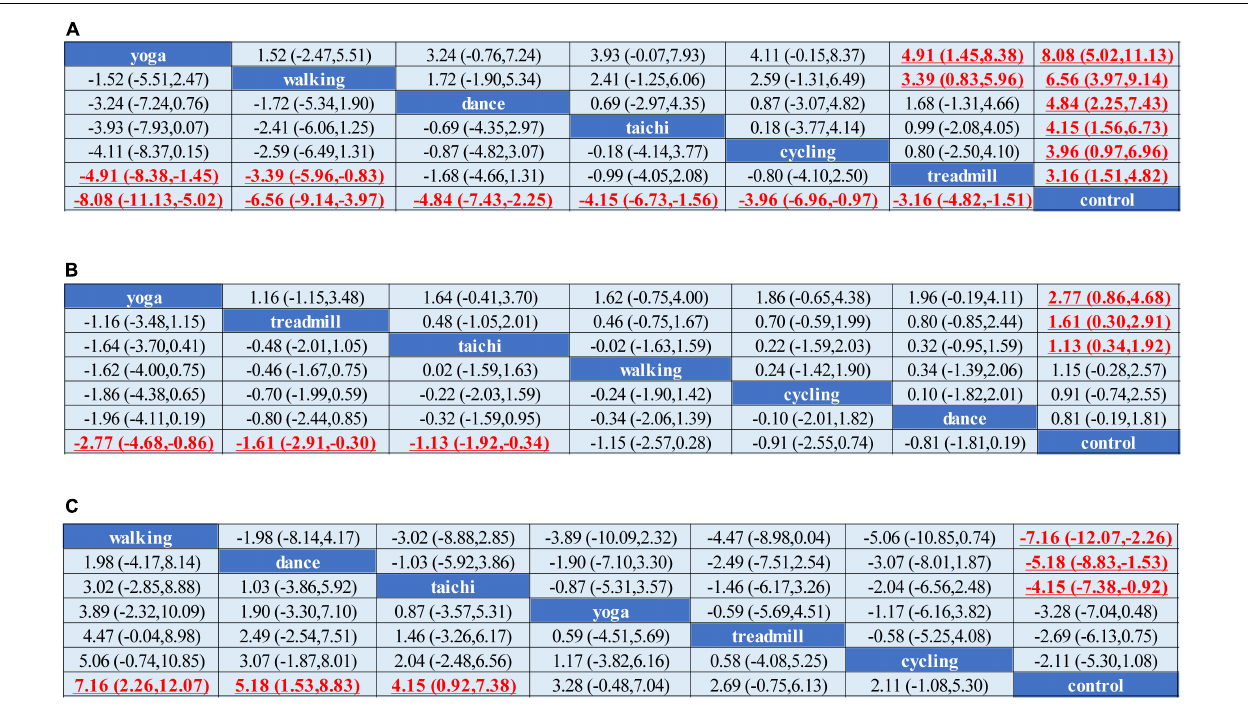
FIGURE 2 | Network meta-analysis of the efficacy of exercise therapies on motor outcomes. (A) UPDRS-motor outcome. (B) TUG outcome. (C) BBS outcome. MD and 95% credible interval (CrI) estimations were calculated as column-defining interventions compared with row-defining interventions. Significant results were labeled with bold, red and